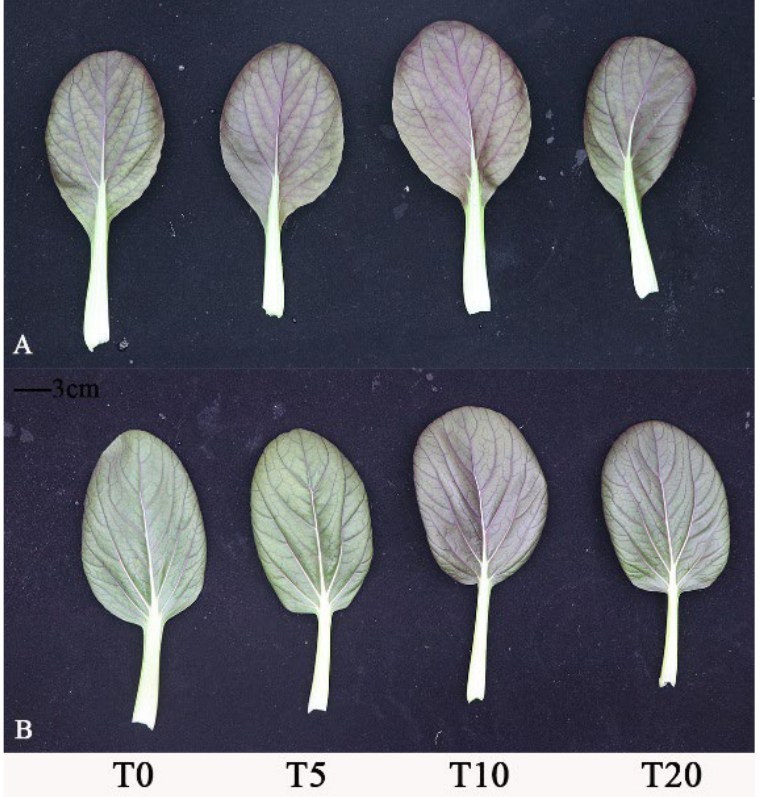
Figure 2 . Effects of blue and UVA light on leaves of red- ( A ) and purple-leaf ( B ) pak choi. T0, T5, T10 and T20 mean 0 UVA with 50 B, 5 UVA with 45 B, 10 UVA with 40 B and 20 UVA with 30 B (μmol·m − 2 ·s − 1 ), respectively.